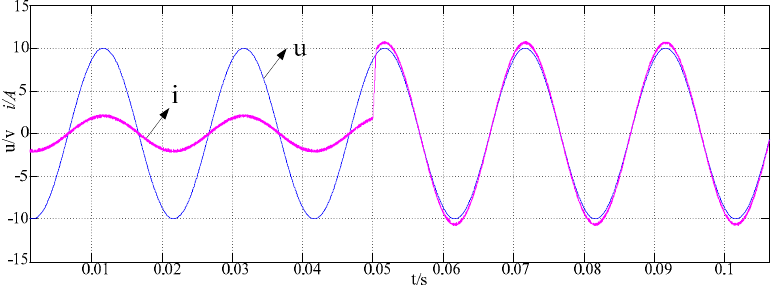
Figure 13. The voltage phase and current phase are consistent.